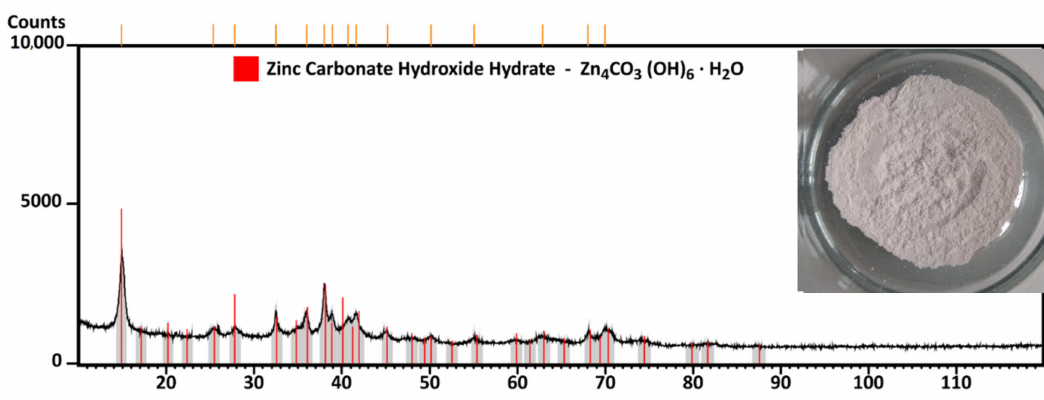
Figure 16. Zinc precipitate after scrubbing and drying.